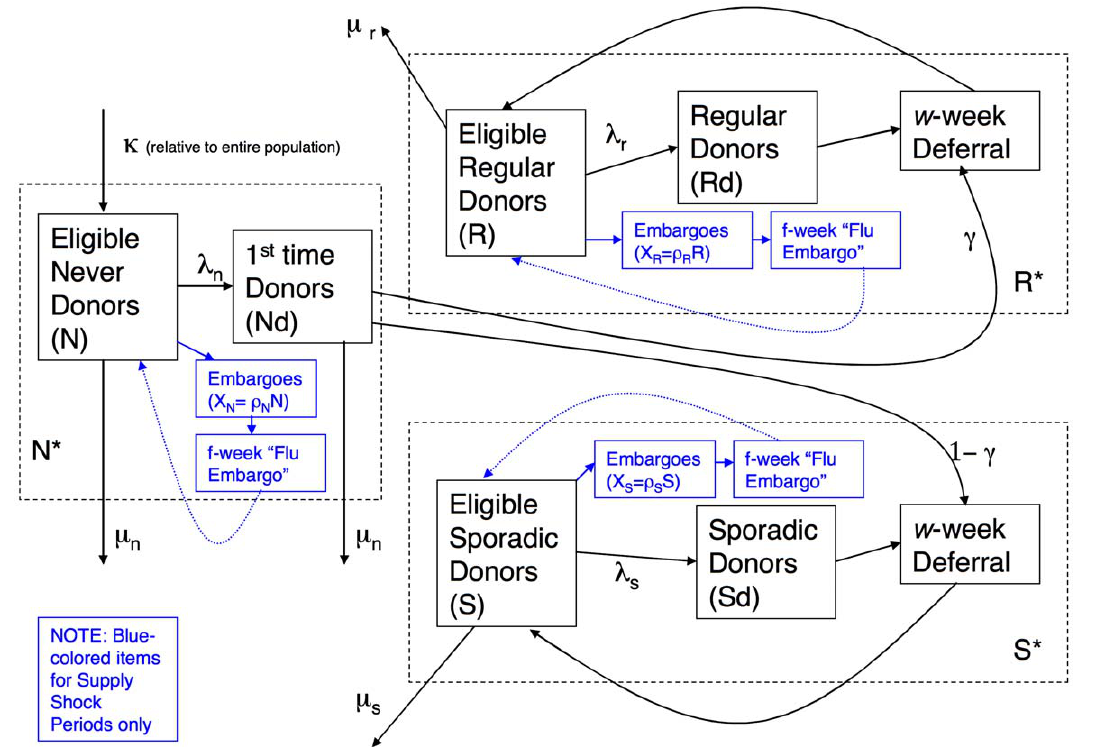
Figure 1. Schematic of the Blood Donation System with three donor states, immigration and emigration, donation and deferral, and transition from first-time donor into either Regular or Sporadic states.